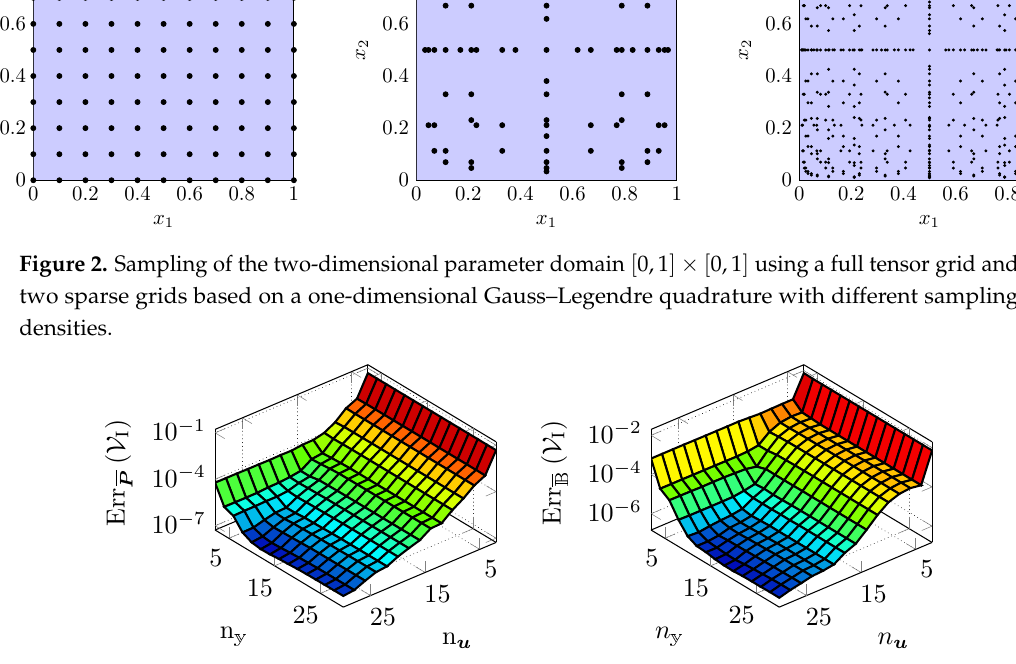
Figure 3. Errors in homogenised quantities of interest for varying sizes of reduced bases n u and n y computed from n s = 4541 training simulations.